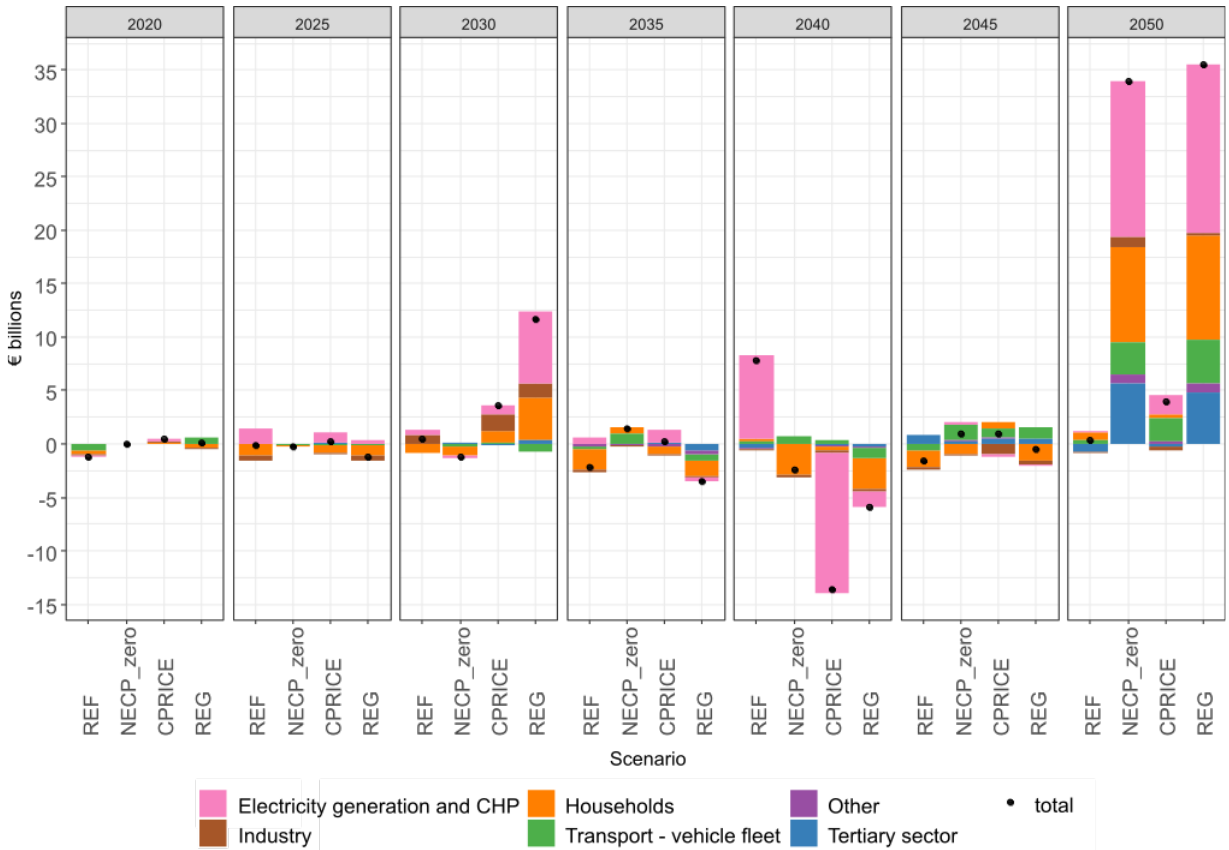
Figure 10. Difference in investment costs compared to NECP scenario (sum over 5-year period, EUR 2020, without VAT).